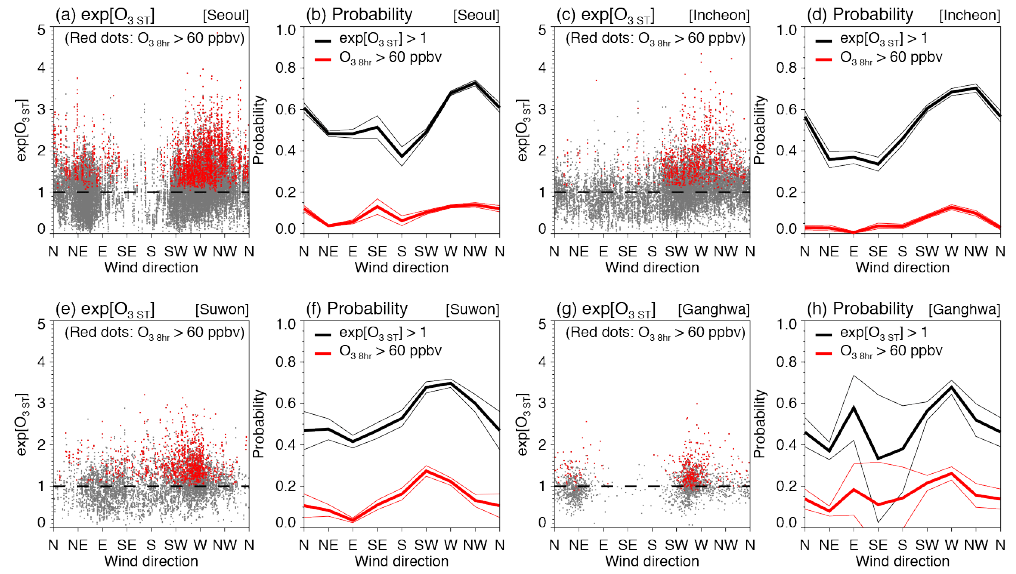
Figure 10. Relationships between WD and exponentials of short-term components (exp[O 3ST ]) during the months of frequent high O 3 events (May–October) at Seoul (a–b) , Incheon (c–d) , Suwon (e–f) , and Ganghwa (g–h) in the SMA are represented in scatter plots of exp[O 3ST ] vs. WD (a, c, e, and g) and probabilities of O 3 exceedances in each WD (b, d, f, and h) . Red dots in scatter plots denote high O 3 episodes in which the daily maximum 8h average O 3 (O 38h ) will exceed the air quality standard of South Korea (60ppbv). Dashed lines in scatter plots denote the reference of exp[O 3ST ] = 1. Probabilities of exp[O 3ST ]>1 and O 38h >60ppbv in each WD are represented as black thick lines and red thick lines, respectively. The black and red thin lines represent the 95% of confidence intervals for each probability. We used O 3 data from 12 sites in Seoul, 6 sites in Incheon, 3 sites in Suwon, and 1 site in